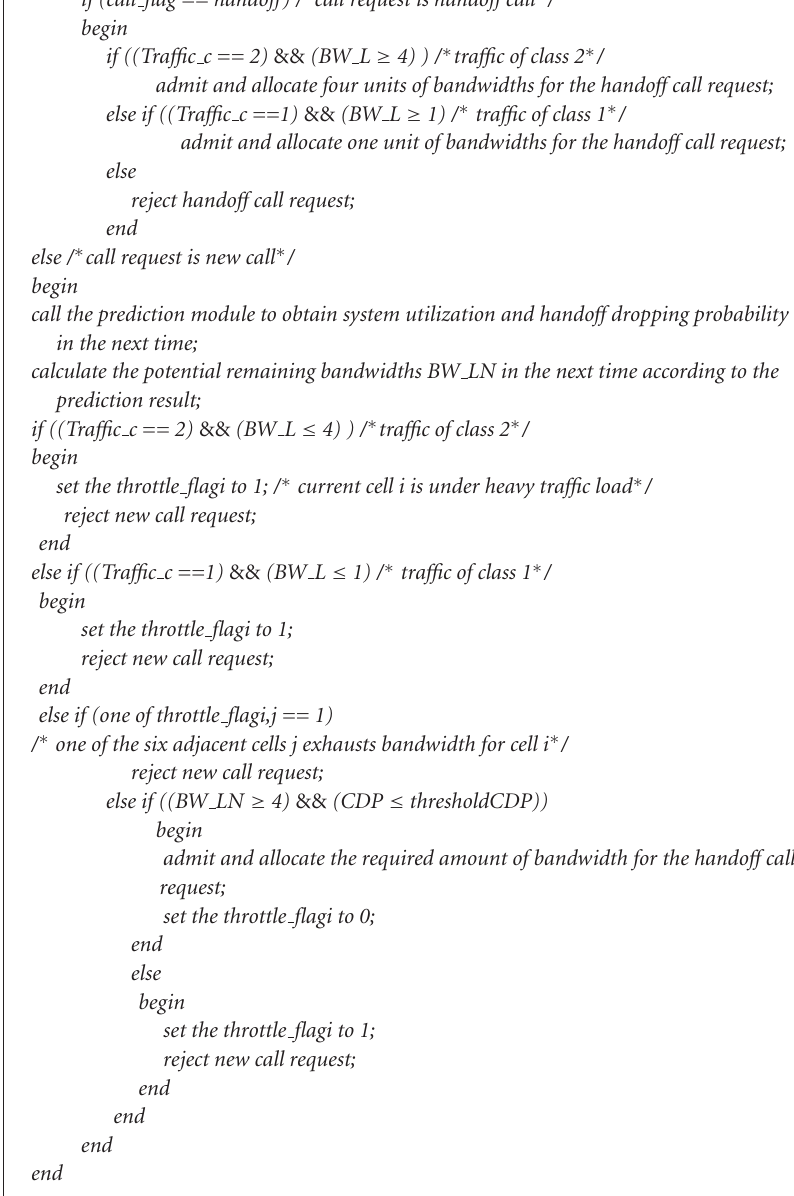
Algorithm 1: TSPCAC (time series prediction call admission